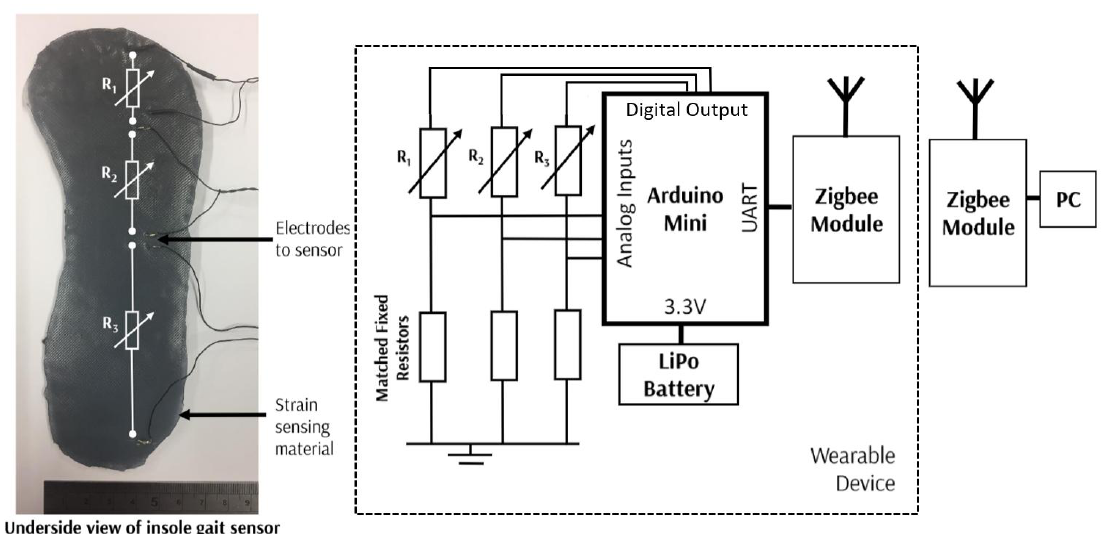
Figure 5. Underside of the soft silicone gait sensor developed showing the attachment to the electrodes ( left ) and the associated circuitry for the system, showing the interface between the sensor and the microcontroller and the wireless system ( right